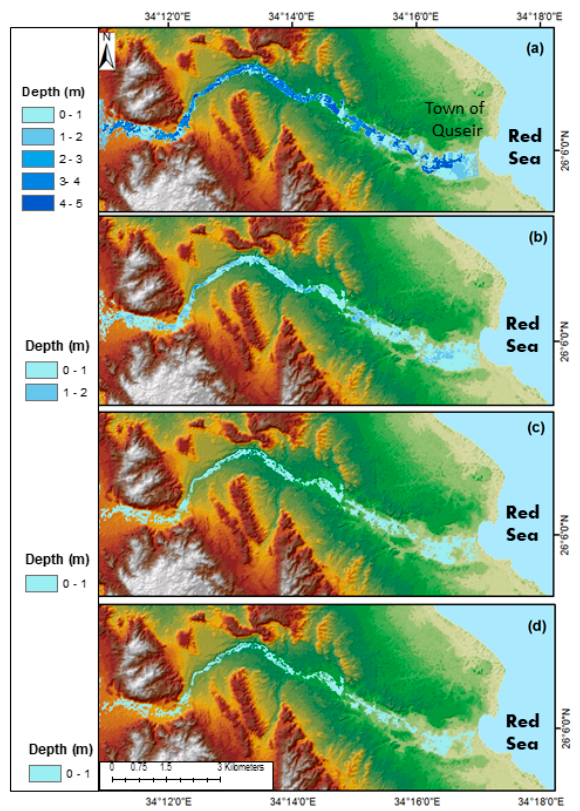
Figure 10. Flood simulations using hypothetical precipitation events and resulting peak flows. A hypothetical precipitation event with a peak flows of 82.5 and 165 m 3 s − 1 would inundate the southern section of the town of Quseir with water depths of up to 1 m. The depth would increase to 2 m and 3 m as a result of peak flows of 875 m 3 s − 1 and 1585 m 3 s − 1 , respectively.